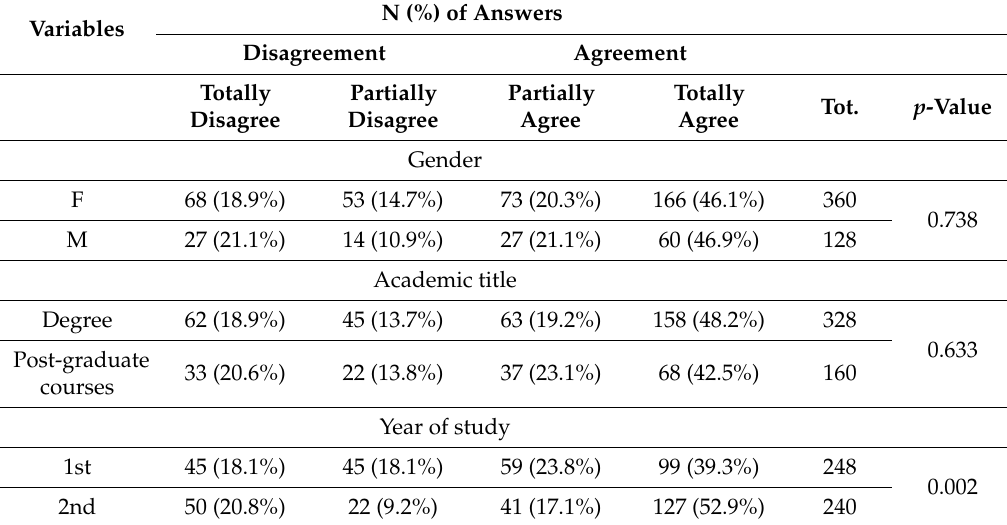
Table 3. Vaccination attitude stratified by gender, academic title, and year of study.